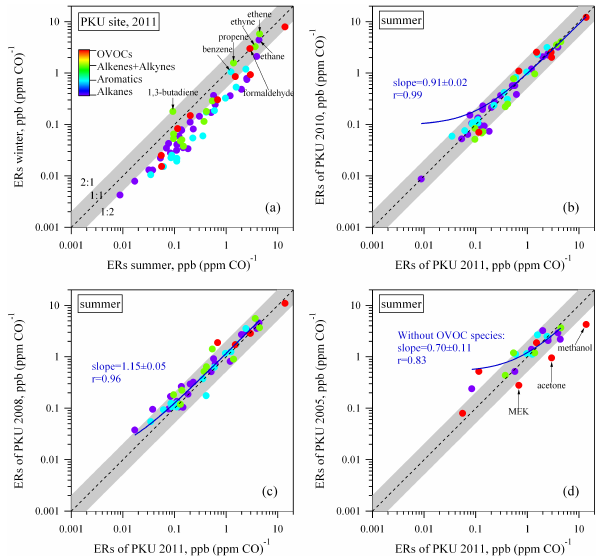
Figure 7. Comparison of emission ratios for VOC species obtained at the PKU site: (a) winter vs. summer, (b) 2010 vs. 2011, (c) 2008 vs. 2011, and (d) 2005 vs.